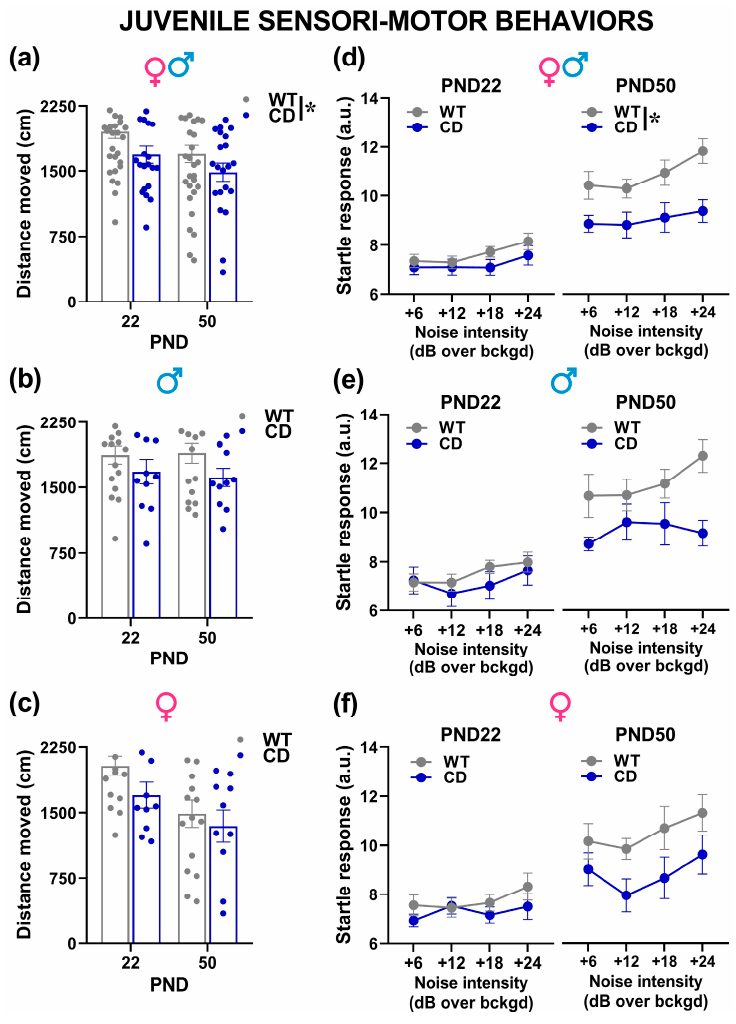
Figure 6. Sensori-motor assessment of juvenile mice. Locomotion was evaluated in the open field ( a – c ), followed on the same testing day by an acoustic startle test ( d – f ). a.u.= arbitrary units. * = p < 0.05. Genotype differences emerged from ANOVA either from a main significant genotype effect ( a ) or from a significant interaction genotype x testing day followed by pairwise comparisons ( d ). Statistical analyses were not conducted separately in males and females since no significant interaction with sex emerged. n = 28 males (17 WT, 11 CD) and 26 females (16 WT, 10 CD). Ultrasonic communication was marginally modulated by the testing day: the mean duration of the USVs increased with days, but in males only [testing day effect in males: F(2,30 = 4.77, p = 0.0159; in females: F(2,48) = 2.38, ns; Figure 7c]. The other quantitative and qualitative characteristics of USVs were mostly stable across days, including the number and call type composition, where no main effect of the testing day emerged in mice of both sexes (Figures 7b and 8). Independently of the testing day, CD female mice emitted more and longer USVs than their WT littermates [genotype effect in females: F(1,24) = 8.07 and 14.59, p = 0.009 and p = 0.0008; Figure 7b,c], while no difference emerged in males [genotype effect: F(1,15) = 0.22 and 0.62, n.s.; Figure 7b,c]. The composition of USVs in terms of call types was also altered in CD females: mutants emitted overall less “short” and more “down” calls compared to their WT littermates, at all testing points [genotype effect in females: F(1,24) = 9.30 and 7.83, p = 0.005 and p = 0.01; Figure 8b,d,f]. No difference emerged in male mice (Figure